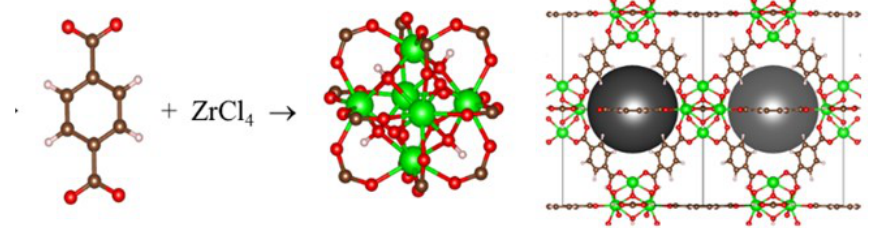
Figure 5. The image of the structural building units and crystal structure of UiO-66 MOF showing the octahedral pores (green depicts Zr, red depicts oxygen, and black depicts carbon).